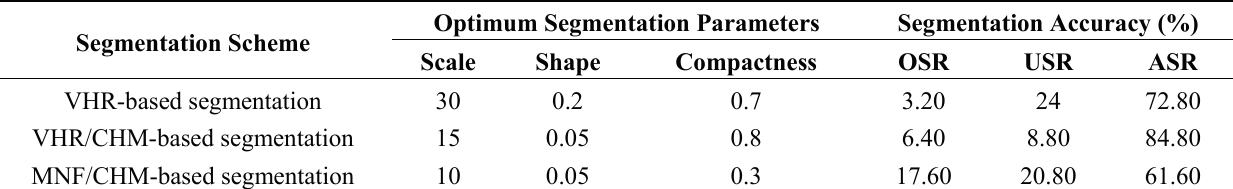
Table 4. Optimum Segmentation parameters and their corresponding results of the different segmentation feature integration schemes.